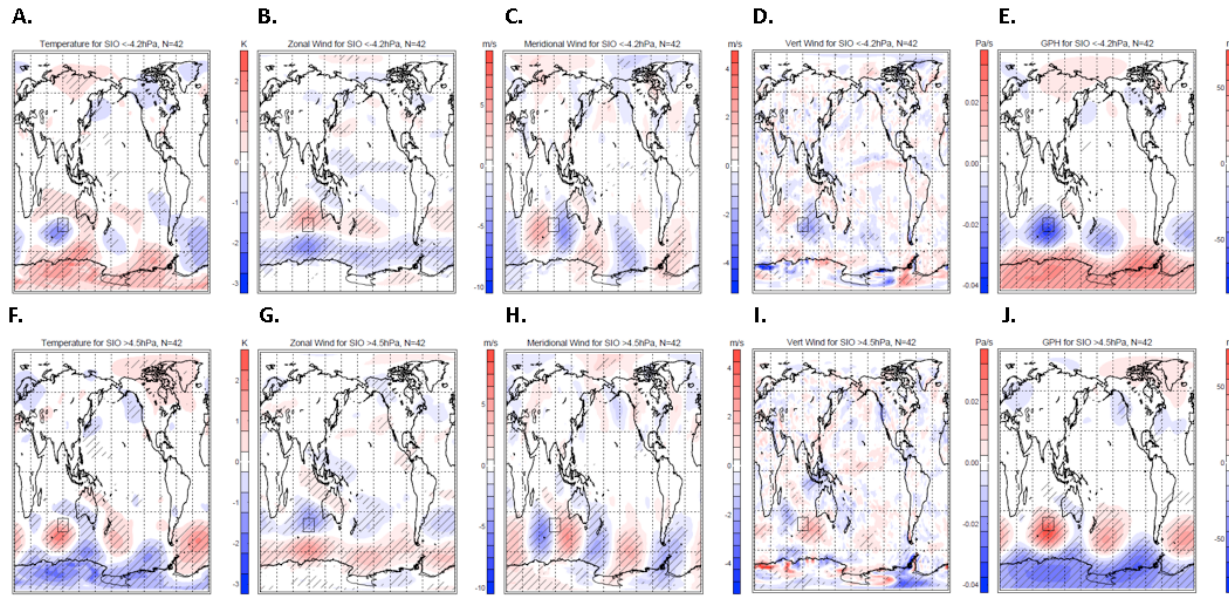
Figure 6. Composites of deseasonalised monthly ERA-Interim fields at 700hPa for surface pressure 10th percentile (negative) and 90th percentile (positive) anomalies in the southern Indian Ocean (SIO) (80–100 ◦ E, 35–45 ◦ S) for 1979–2012 (Dee et al., 2011). Shown are temperature (a, f) , zonal wind speed ( b, g ; positive = eastward) and meridional wind speed ( a, f ; positive = northward), vertical pressure wind ( d, i ; positive = downward) and geopotential height (e, j) . The SIO surface pressure anomaly threshold and the number of months ( N ) contributing to each composite are shown along the top of each panel. Hatched areas denote areas of statistical significance (95%